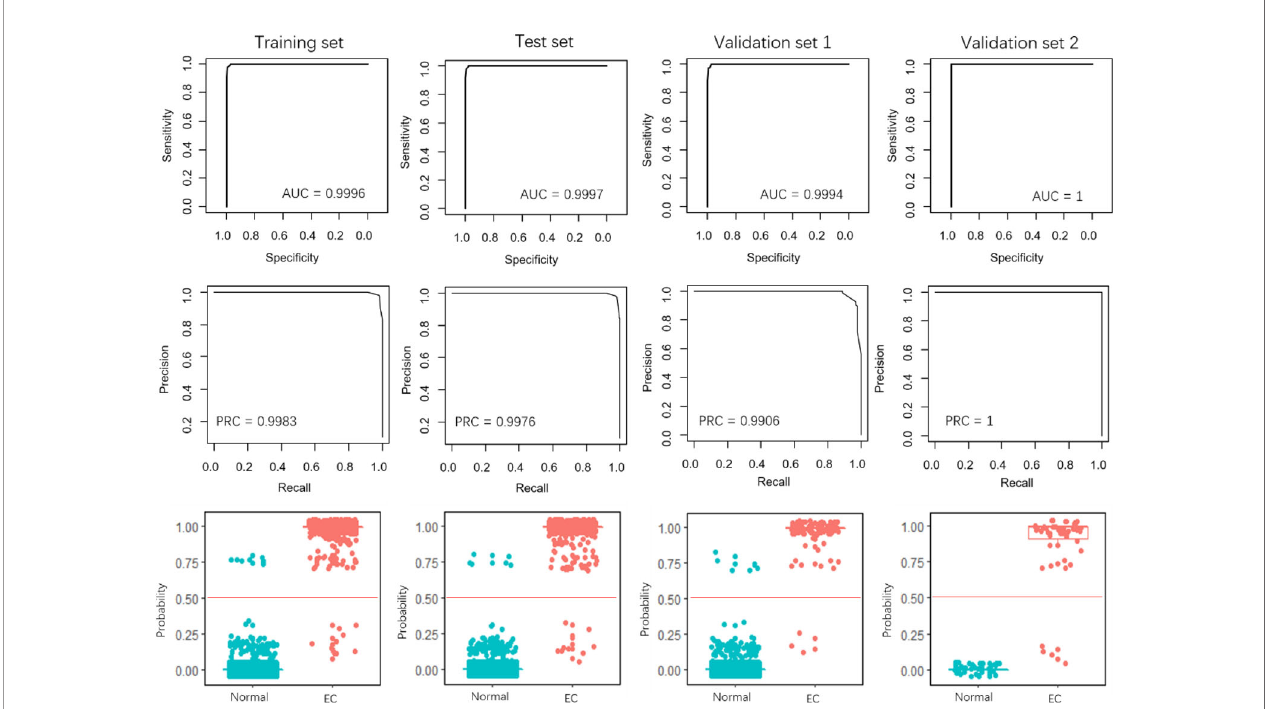
FIGURE 3 | Performance evaluation of the 4-miRNA pair signature. The fi rst row and the second row show the ROC and PRC curves for the training set, test set, and the two validation sets. The third row illustrates the prediction probability of the EC and normal samples in the four data sets.